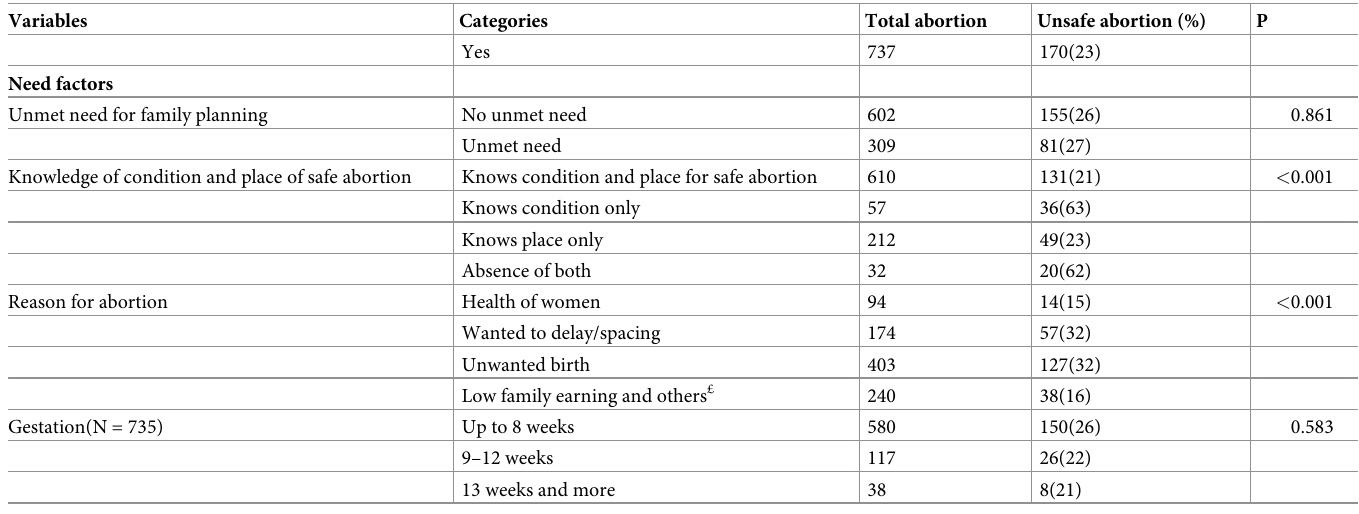
Table 2 shows the results of bivariate and multivariate regression analyses of independent vari- ables and unsafe abortion in Nepal. The bivariate logistic regression showed that rurality (urban), eco-region (Mountain), development region (mid-western), wealth index (middle or poor), ethnicity (Dalit, or Madhesi and Muslim), maternal education (primary or no educa- tion), women’s literacy level (cannot read), husband education (primary or no education), maternal occupation (agriculture or no occupation), knowledge on legal conditions of abor- tion and safe abortion sites, exposure to general mass media (yes), and exposure to mass media on public health issues, number of male children ( � 2), number of female children (one), sex of the most recent children (female), reasons for abortion (want to delay/space child-bearing, or unwanted child) were all significantly associated with unsafe abortion at p < 0.05 [Table 2]. The final regression model [Table 2] revealed that women residing in the mountain region